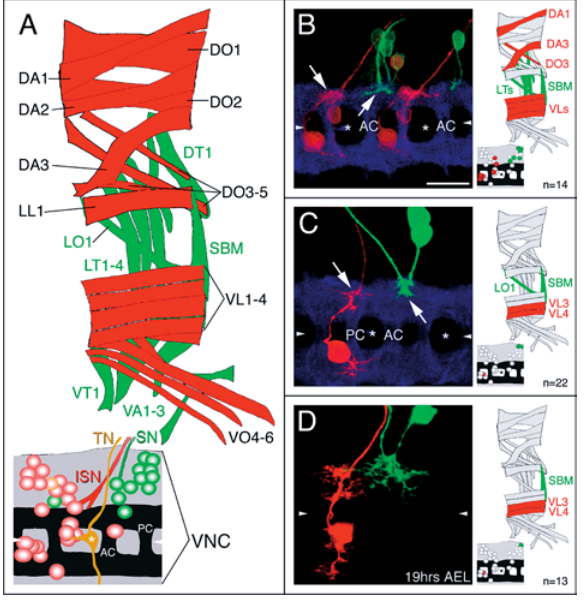
Figure 1. Organisation of the Larval Motor System (A) Diagrams of abdominal body wall muscles of one half segment (top) and of the VNC (bottom). These diagrams are included in most subsequent figures as reference for the relative positions of muscles and their innervating motor neurons. Internal muscles are red; external muscles, green. Muscle nomenclature is according to Bate (1993): muscle position (D, dorsal; L, lateral; V, ventral), followed by orientation (A, acute; L, longitudinal; O, oblique; T, transverse) and SBM. In the VNC, cell bodies of motor neurons innervating an abdominal half-segment are indicated: red shows ISN with internal muscle targets; green shows SN with external muscle targets. The TN (brown) coincides approximately with the segment boundary. TN exit glia (asterisk) located on the ventral midline are also shown. The neuropile is indicated in black. (B and C) Retrograde fills of ISN and SN motor neurons in 15-h-old wild-type embryos. The neuropile (blue) was visualised with anti-HRP. ISN and SN motor neurons innervating muscles in the same segment elaborate their dendrites (arrows) in distinct regions. In (B), groups of ISN and SN motor neurons are labelled in two consecutive segments. In (C), individual ISN and SN motor neurons of a segment are shown. (D) The separation between ISN and SN motor neuron dendrites appears to be maintained, at least until 19 h AEL, when the motor system is functional. Anterior is left and dorsal is up. Symbols and abbreviations: triangles, ventral midline; AC, anterior commissure; PC, posterior commissure; asterisks, TN exit glia in (A) and dorsoventral channels, which are landmarks for the segment borders, in (B)–(D). Scale bar (not applicable to diagrams of CNS and muscle field): (B) 18 l m; (C– D) 14 l m. n numbers refer to the number of segments in which the same types of motor neurons (e.g., RP3 and SBM in [C]) were labelled. DOI: